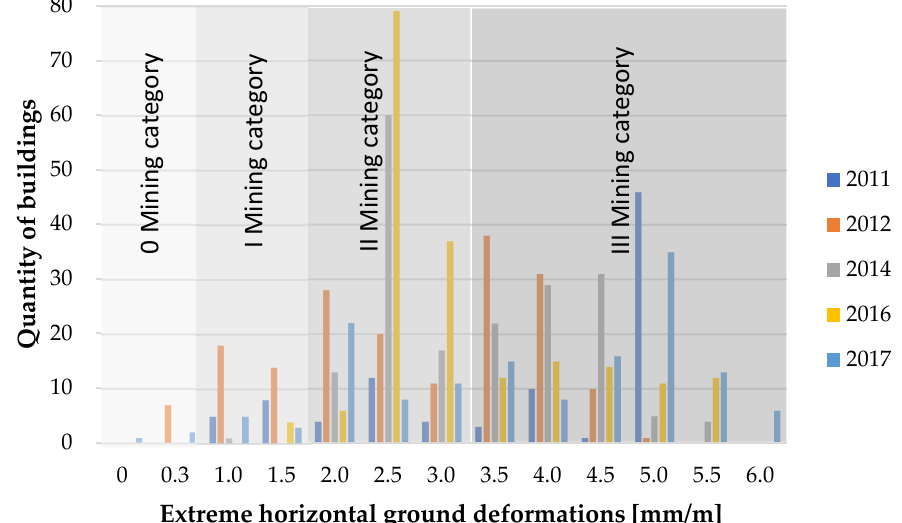
Figure 5. Occurrence of horizontal ground deformations [mm/m] at the location of analysed buildings from 2011 to 2017.